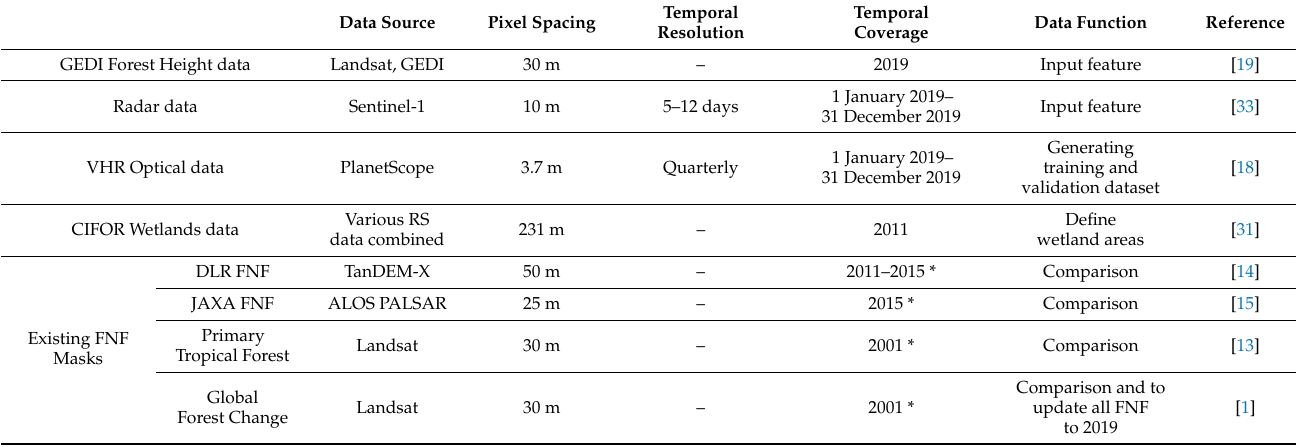
Table 1. Overview of the satellite data and products used in this study. * The FNF masks were updated to the year 2019 by removing annual forest loss information available via the Global Forest Change product [1]. Data Source Pixel Spacing Temporal Resolution Temporal Coverage Data Function